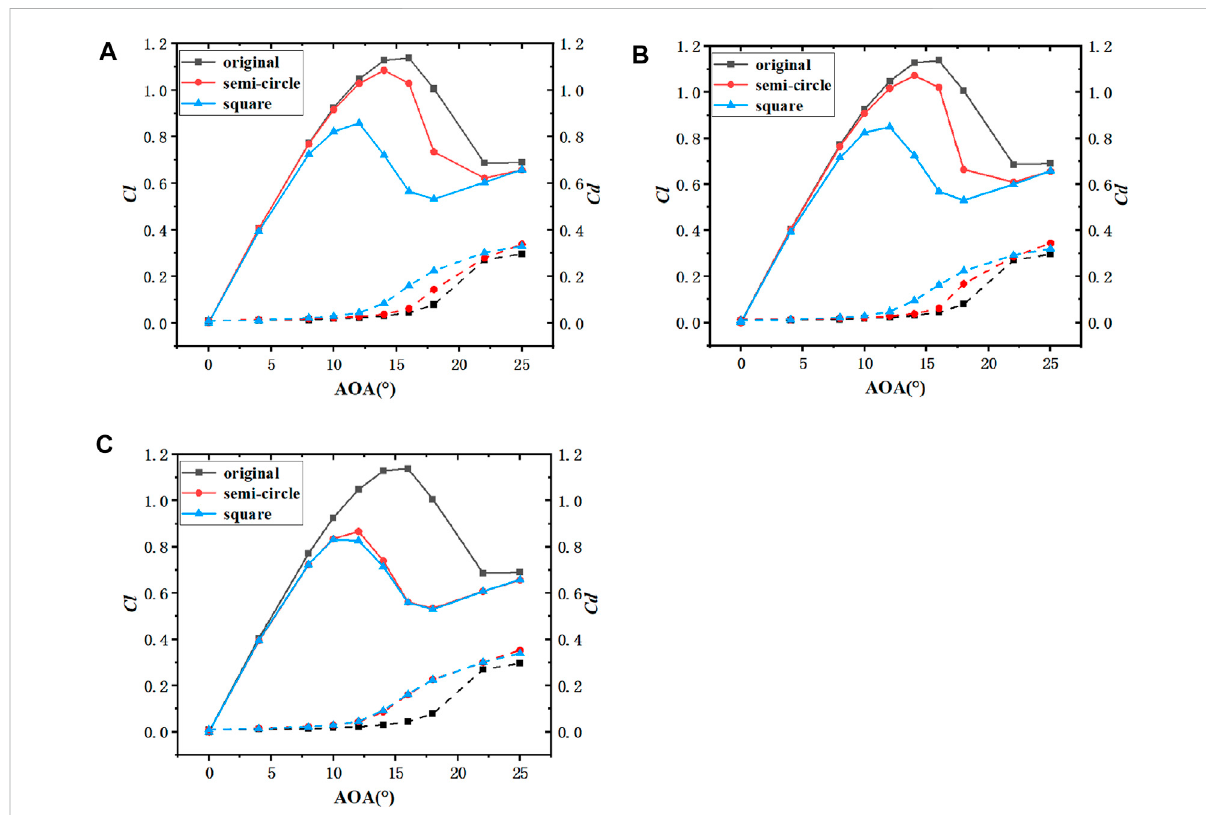
FIGURE 22 Comparison of Lift and drag coef fi cients of NACA0015 original airfoil with semi-circle and square leading edge erosion airfoil. ( (A) : h 1 = h 2 = 0.3% c ; (B) : h 1 = h 2 = 0.5% c ; (C) : h 1 = h 2 = 1% c